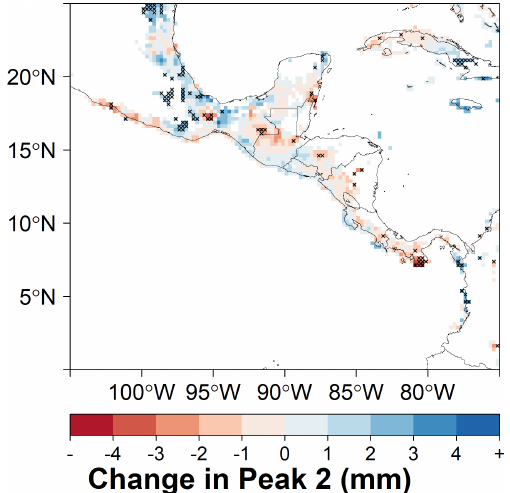
Figure A6. The change in MSD duration between the early (1981– 2000) and late (2001–2020) periods. Grid cells marked with an “X” show statistically significant